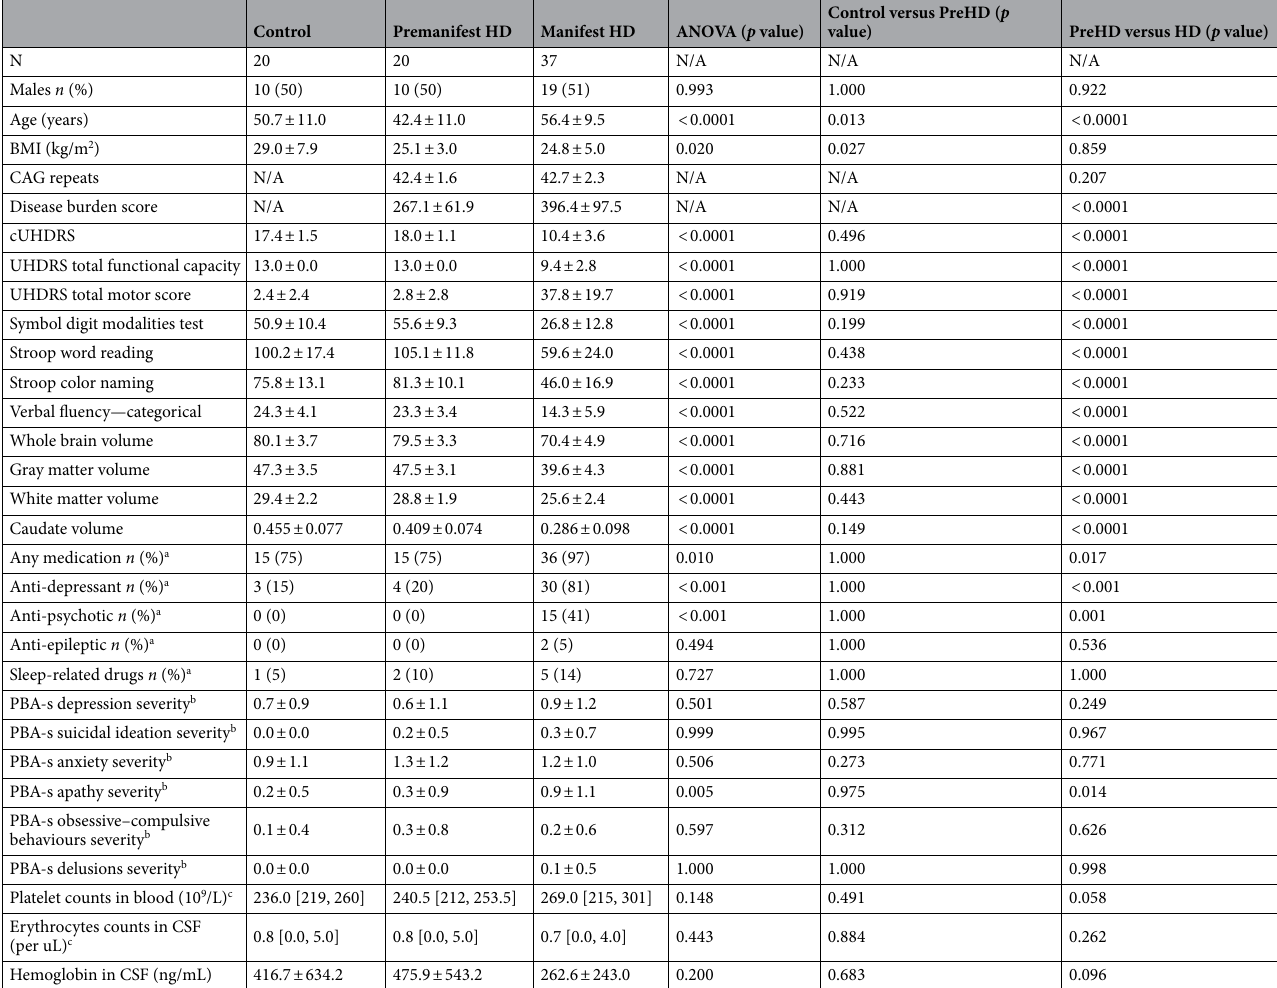
Table 1. Baseline characteristics of the HD-CSF cohort. Presented p values are not adjusted for multiple comparisons. Results were replicated at follow-up. Brain volumes are percentages of total intracranial volume. Values are mean ± SD, except where it stated otherwise. Manifest HD, manifest HD mutation carriers; Premanifest HD/preHD, premanifest HD mutation carriers; SD, standard deviation; ANOVA, analysis of variance; PBA-s, Problem Behaviours Assessment-short version; CSF, cerebrospinal fluid; BMI, body-mass index; cUHDRS, composite Unified Huntington’s Disease Ratings Scale; UHDRS, Unified Huntington’s Disease Ratings Scale; N/A, not applicable. a Fisher’s exact test. b Ordinal logistic regression. c Median [Q1,